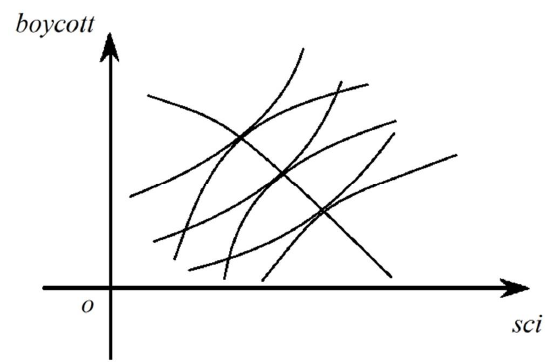
Figure 2. “Equal boycotted cost line,” “Equal boycott cost line” and “Isoclinic”. There is only one “ equal boycotted cost line ” and one “ equal boycott cost line ” at any point in the quadrant. If the slope of the equal boycott cost curve is greater than the slope of the equal resisted cost curve at this point, it satisfies the condition that the promoting effect is greater than the suppressing effect, that is, social capital promotes pollution at this time and vice versa. If the two curves are tangent at the point, then the two effect cancel each other. The set of points meeting this condition is drawn out to form an oblique downward isoclinic, which is the downward inclined curve in Figure 2. The points at the upper right of the isoclinic satisfy the condition that the suppressing effect is greater than the promoting effect. When the level of social capital increases, as both bcted-Z